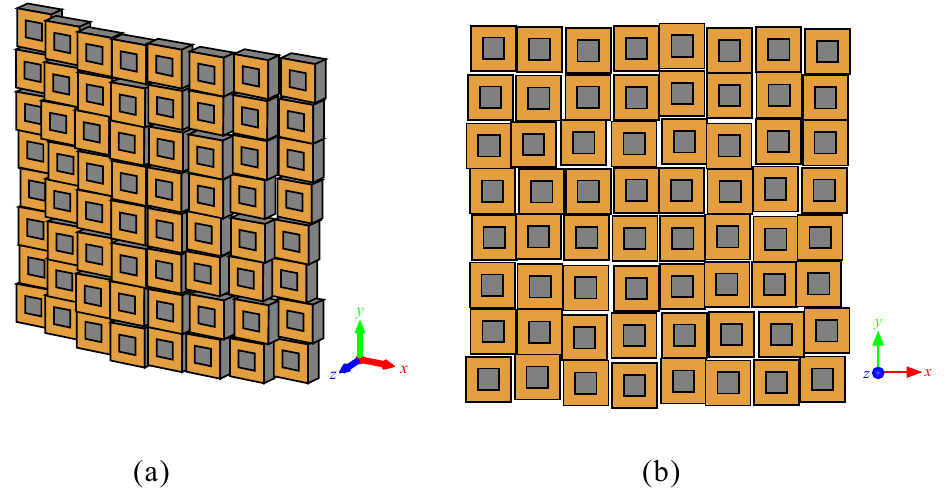
Figure 7. 8 × 8 random grid array shape: ( a ) 3D view and ( b ) XY plane view.